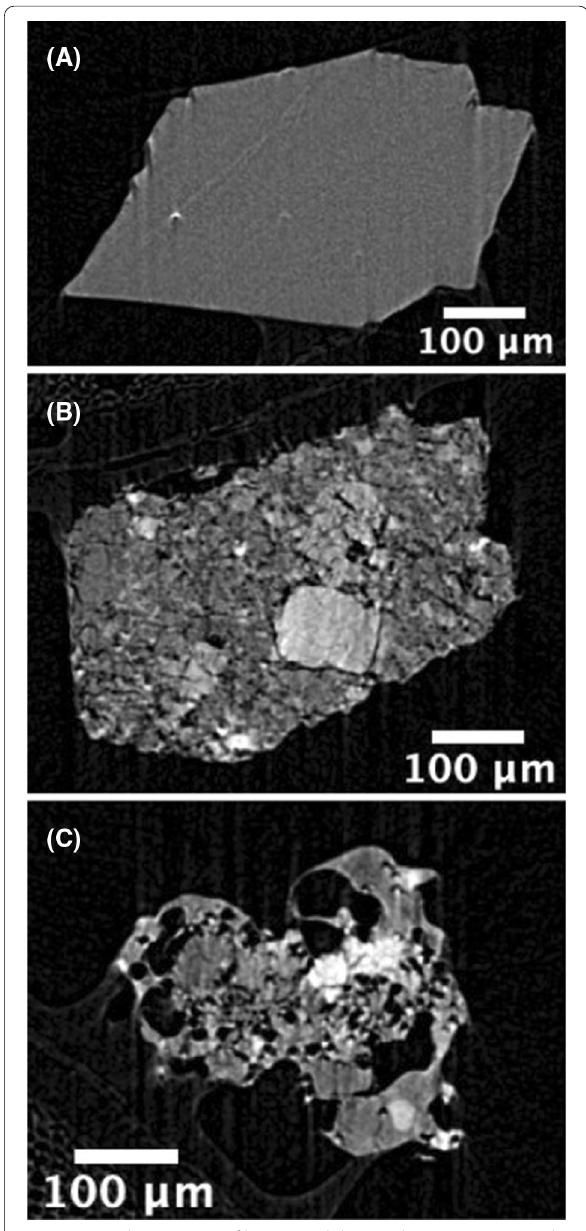
Fig. 1 Typical CT images of lunar regolith particles. A Monomineralic (m-type) particle. B Polymineralic (p-type) particle. C Agglutinate (ag-type) particle. Luna24 sample